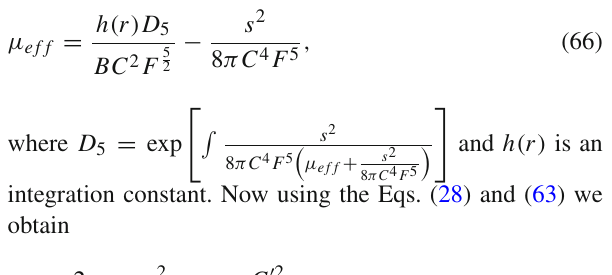
Fig. 3 The plot is for κ = 0 , m = 1 . 4 and s = 0 . 5 which corresponds to flat